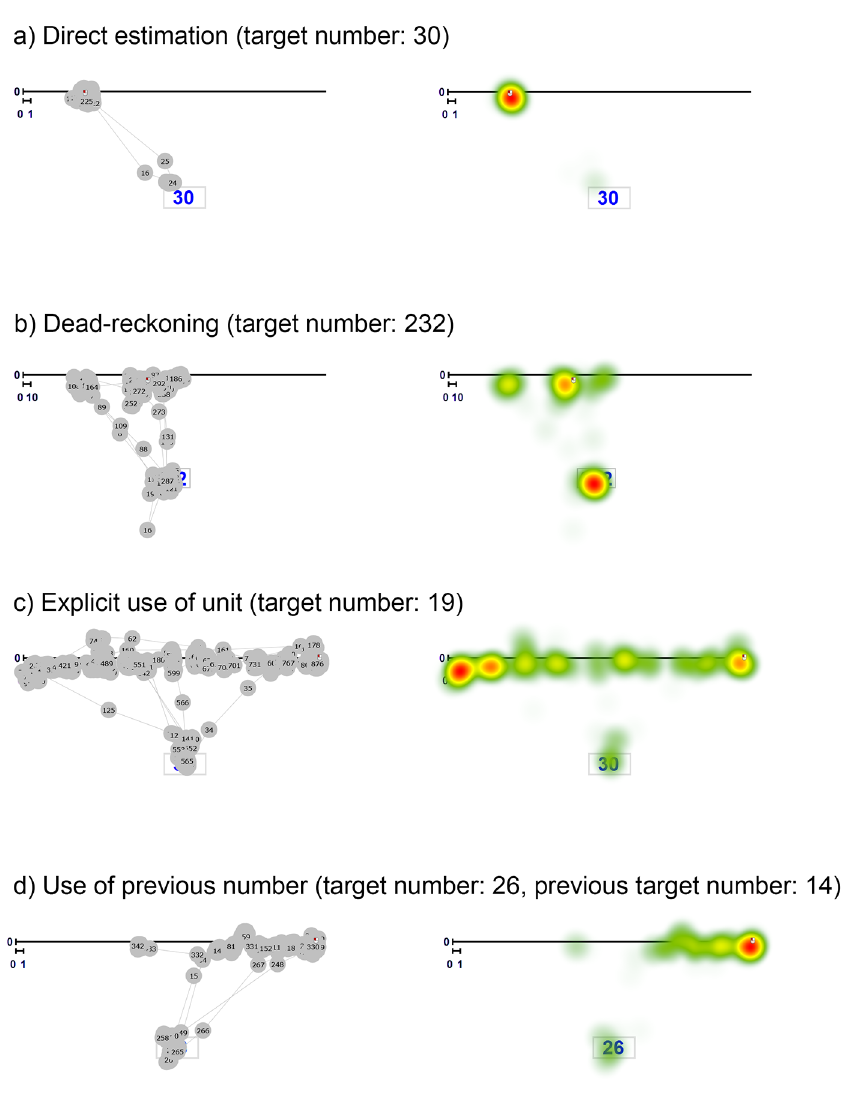
Figure 7. Gaze patterns examples of strategies used during the unbounded NLT. On the left, gaze patterns are displayed, in which dots represent eye fixations and lines represent utterances (eye movements). On the right, heat maps are displayed, in which the color indicates the duration of fixations at a specific location. Green indicates short fixations, yellow indicates fixations of medium duration, and red indicates long